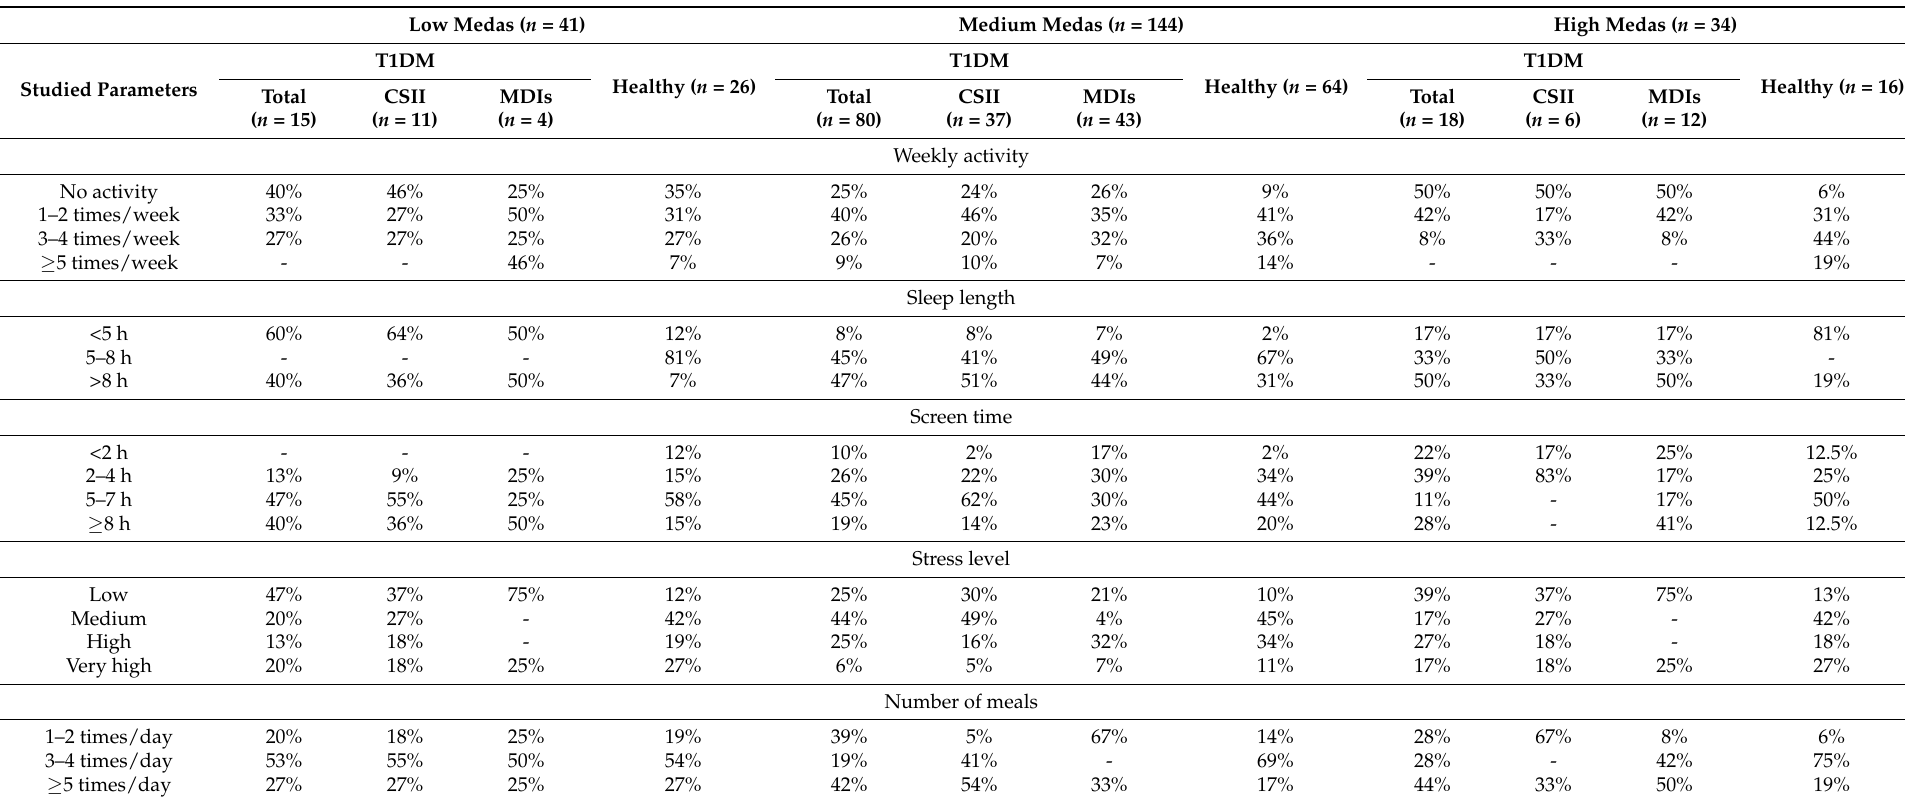
Table 4. Health behaviors depending on the Mediterranean Diet Adherence Screener (MEDAS) score